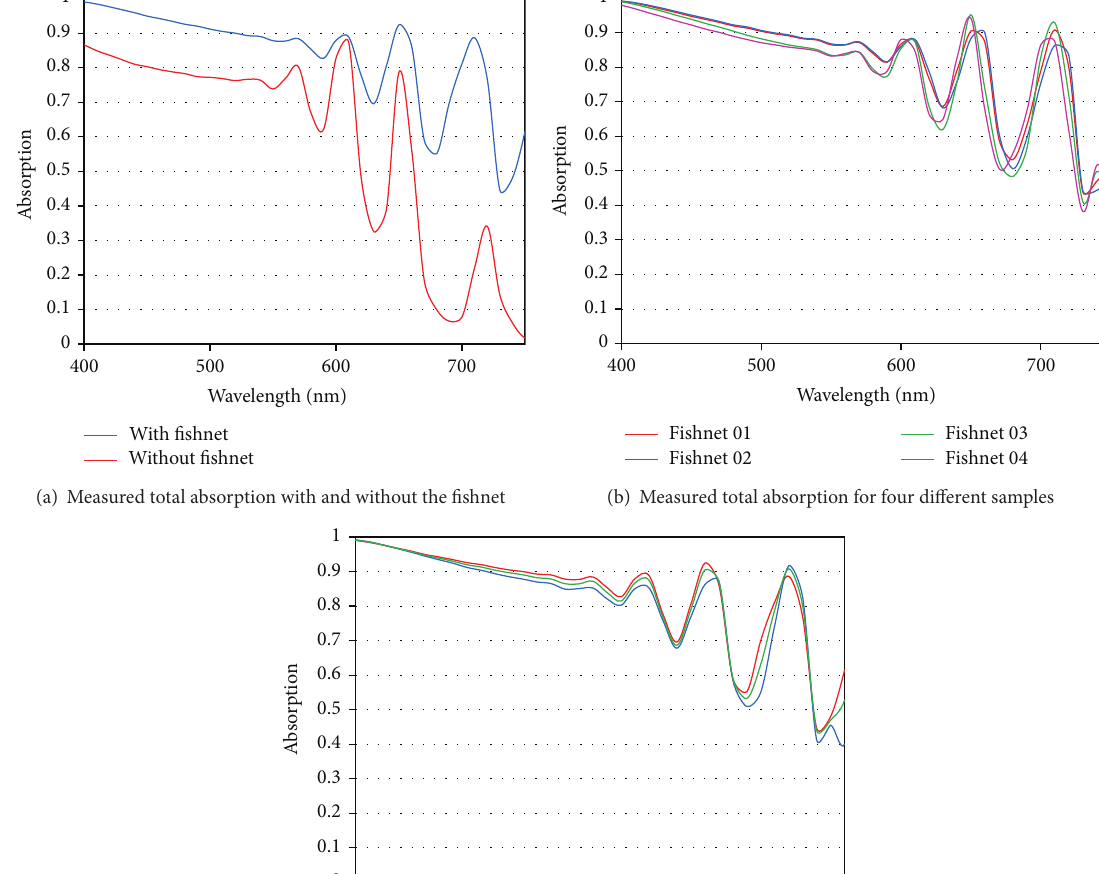
(c) Measured total absorption for different polarizations Figure 5: Measurement of total absorption.